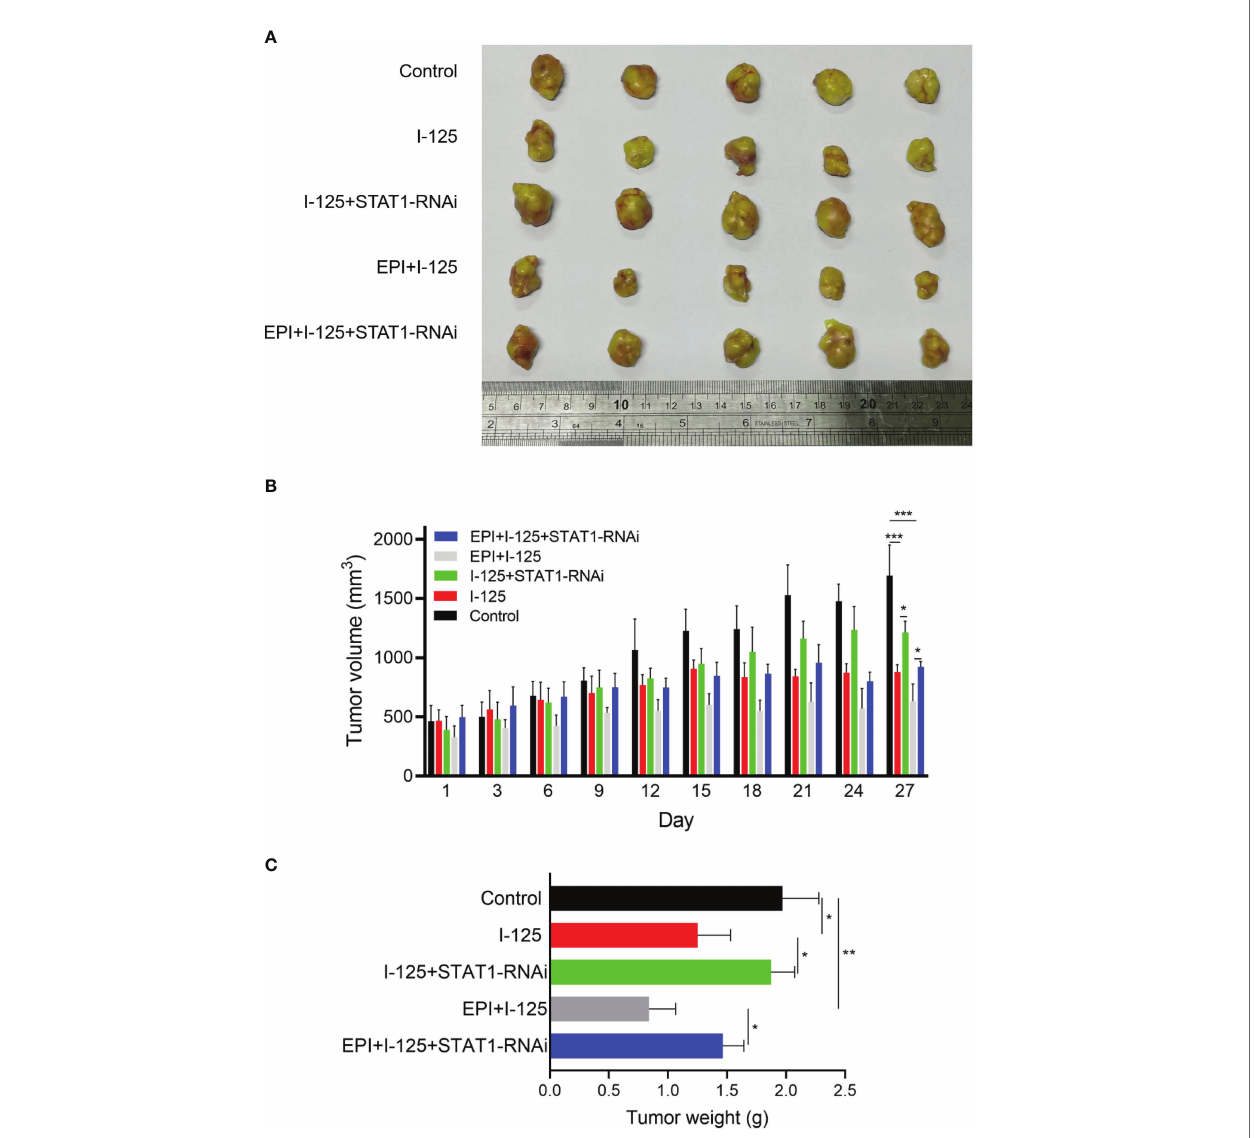
FIGURE 6 | Attenuation of the anti-cancer effect induced by 125 I and EPI by STAT1 downregulation in vivo . Nude mouse model was created using SMMC7721 cells transfected with NT-RNAi or STAT1 -RNAi and treated with 125 I and EPI. (A) The tumor models were treated and stripped, showing the volume of 5 tumors in each group. (B, C) Tumor volume and weight in each group were measured and the results were shown. The data were expressed as mean ± standard deviation. * P < 0.05, ** P < 0.01, *** P < 0.001. EPI,